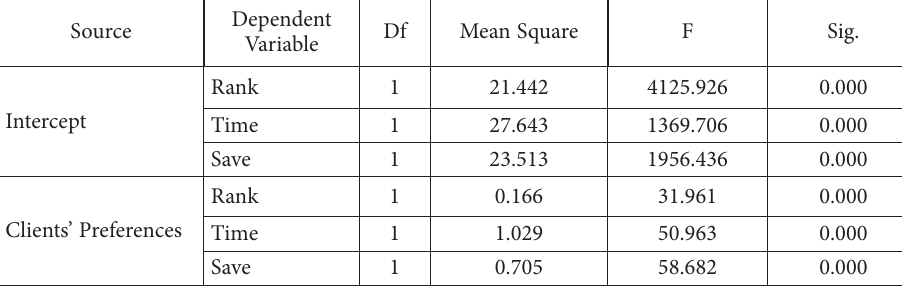
Table 4. Manova model of the measurement of information